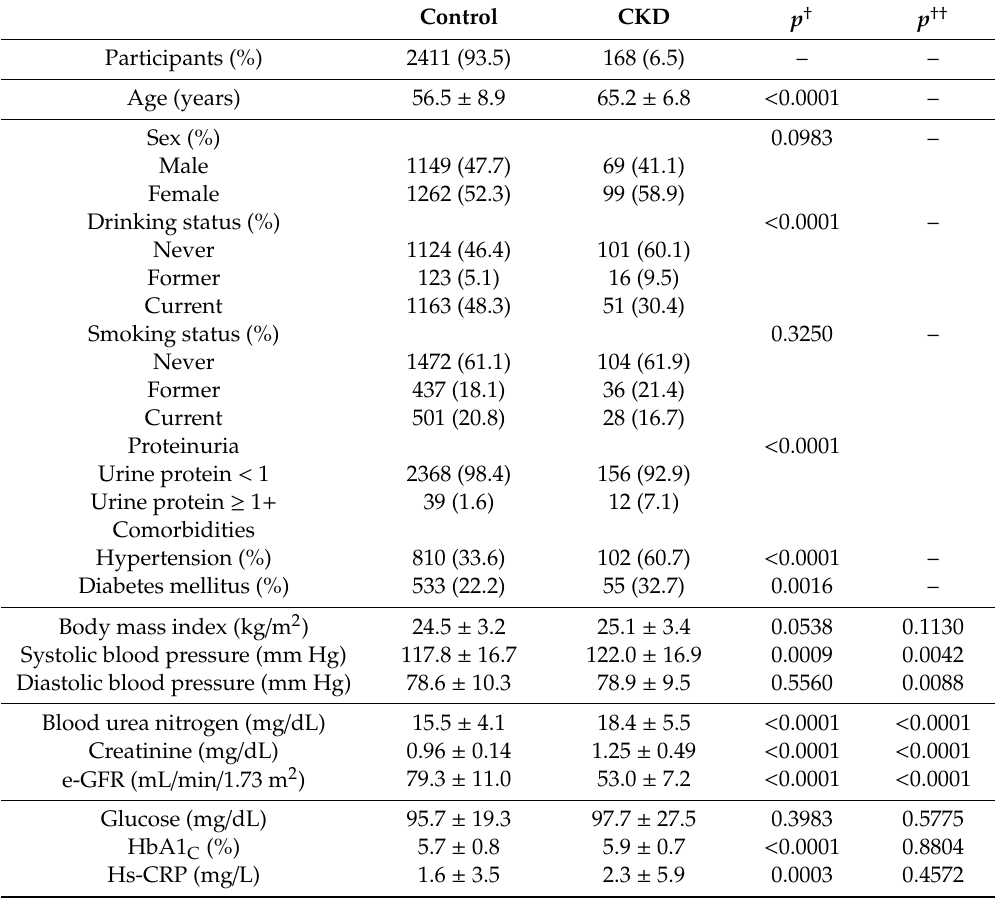
Table 1. Baseline characteristics of subjects with and without chronic kidney disease